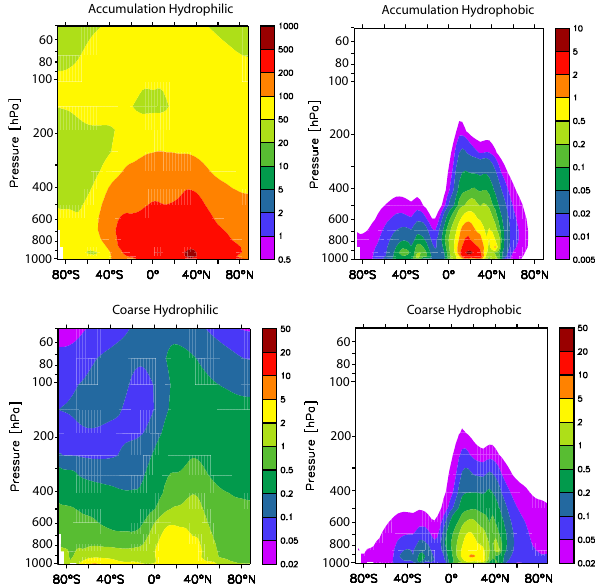
Fig. 2. Zonal and annual mean aerosol number concentration (converted to STP conditions at 1013.25hPa and 273.15K, cm − 3 ) for the year 2001 for the (top left) nucleation hydrophilic, (bottom left) Aitken hydrophilic and (bottom right) Aitken hydrophobic modes as simulated by GMXe.